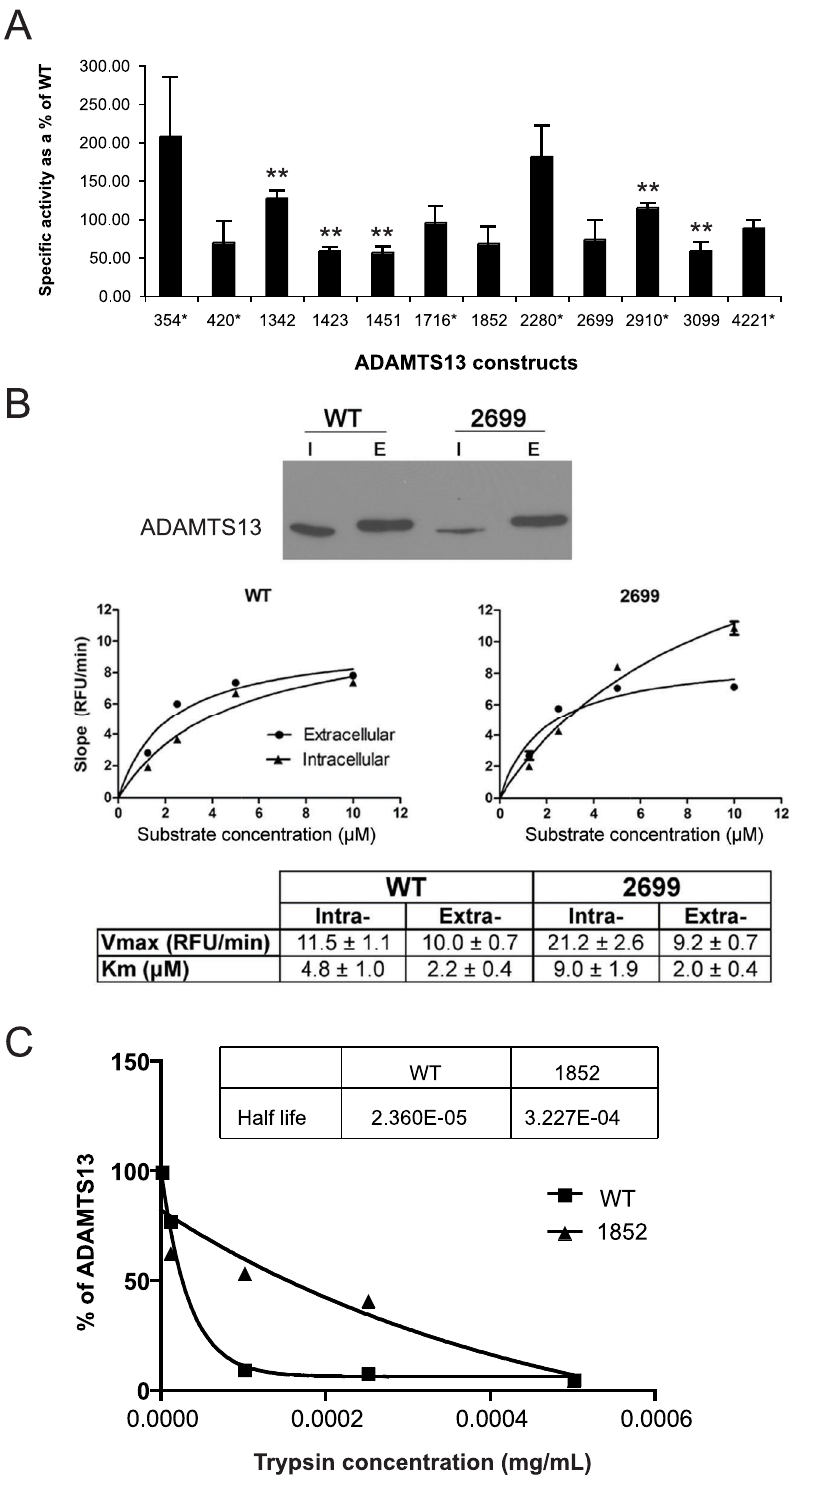
Figure 3. Specific activity of ADAMTS13 variants and limited proteolysis with trypsin. A. Specific activity of twelve ADAMTS13 variants vs. WT as determined using FRETS-VWF73 substrate: Samples containing equal amounts of total extracellular protein were incubated with 5 m M of FRETS-VWF73 substrate and fluorescence readings were taken at 5 min intervals over the course of 2 h. Specific activity was calculated as the increase in relative fluorescence units (RFU)/min per unit of ADAMTS13 in the total extracellular protein samples. Extracellular ADAMTS13 protein amounts were determined using immunoblot analysis with anti-V5 antibody as in Figure 2. ADAMTS13 variants harboring synonymous variants are marked with (*) (**p-value , 0.05). B. Expression and Michaelis-Menten Kinetics of non-synonymous variant 2699 vs. WT protein: HEK293 cells were transfected with WT and non-synonymous variant 2699 and harvest 24 h. post-transfection. Samples containing equal total protein amounts, both intracellular (I) and extracellular (E) (40 m g each), were separated by SDS-PAGE and probed with anti-V5 antibody to determine ADAMTS13